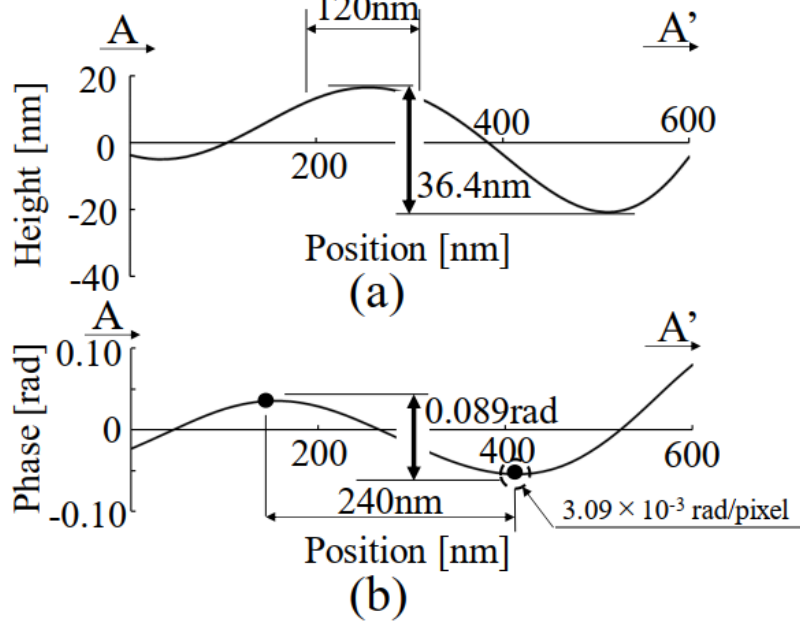
Figure 14. Cross-section of measured object. ( a ) Cross section of shape on A-A’ in Figure 13; ( b ) Cross section of difference value on A-A’ in Figure 13.